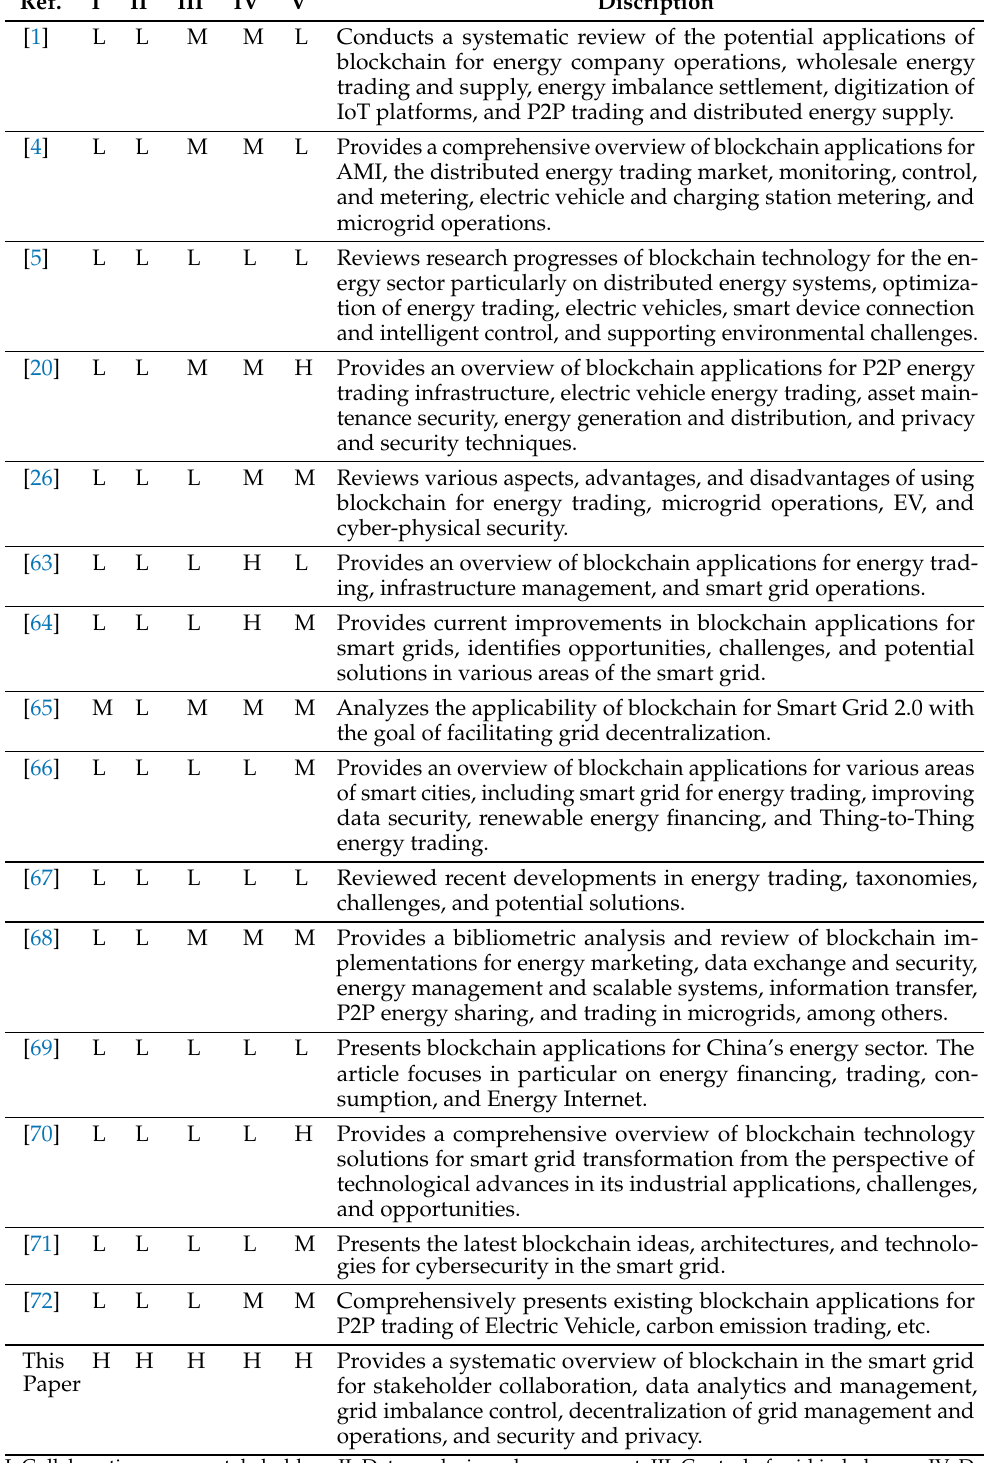
Table 3. Summary of typical surveys and reviews on blockchain challenges for smart grid manage- ment, control, and